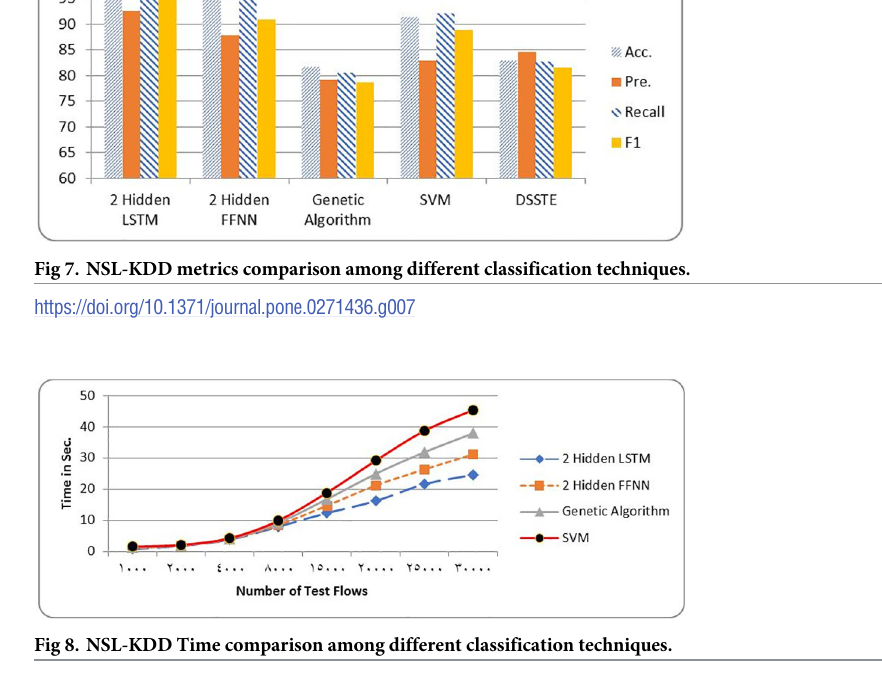
Table 7 show the advanced metrics obtained from the confusion matrix in Table 8. The